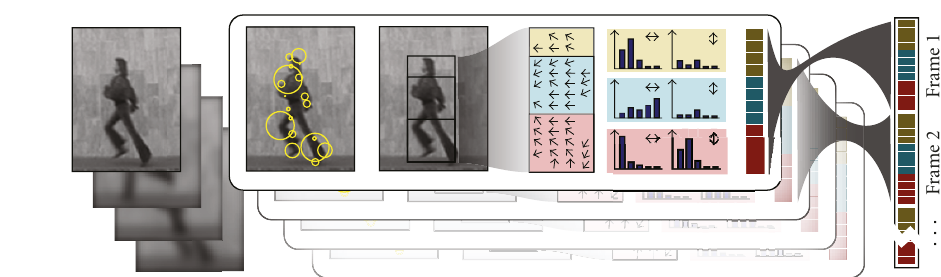
Figure 4: The features used in supervised case are described in [19]; a single feature vector (right) is computed for each sequence, by concatenating data coming from each frame of the sequence (left). In each frame, Harris interest points are used to recover a tight bounding box, which is vertically partitioned in three regions. The topmost 1/5 of the bounding box approximately contains the head and the neck. The middle 2/5 contains the torso and hands, whereas the bottom 2/5 of the bounding box contains the legs. Such segmentation is obviously approximated, and the resulting features would still be usable in cases where the assumptions are not met. Flow data in each region is summarized in separate histograms for the horizontal and vertical